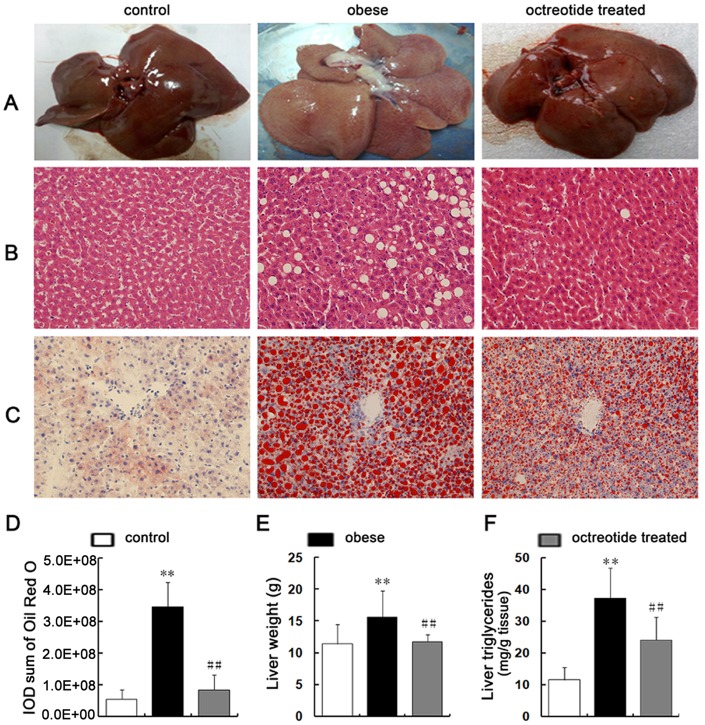
Reduction of hepatic steatosis with octreotide treatment.Compared to the livers in the control group, typical hepatic steatosis was evidenced by a faint yellow color (A), a larger unstained area that consisted of fat vacuoles (B; H&E-stained; ×400 magnification), a larger red area that consisted of lipid droplets (C, D; oil red O staining; ×400 magnification), heavier livers (E), and higher TG contents (F) in the livers of the obese group. Octreotide treatment significantly reversed these changes in the liver. **p<0.01 vs. control group; ##p<0.01 vs. obese group.